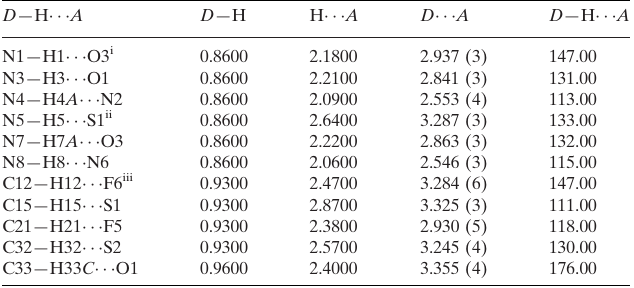
Hydrogen-bond geometry (A˚ , (cid:2)